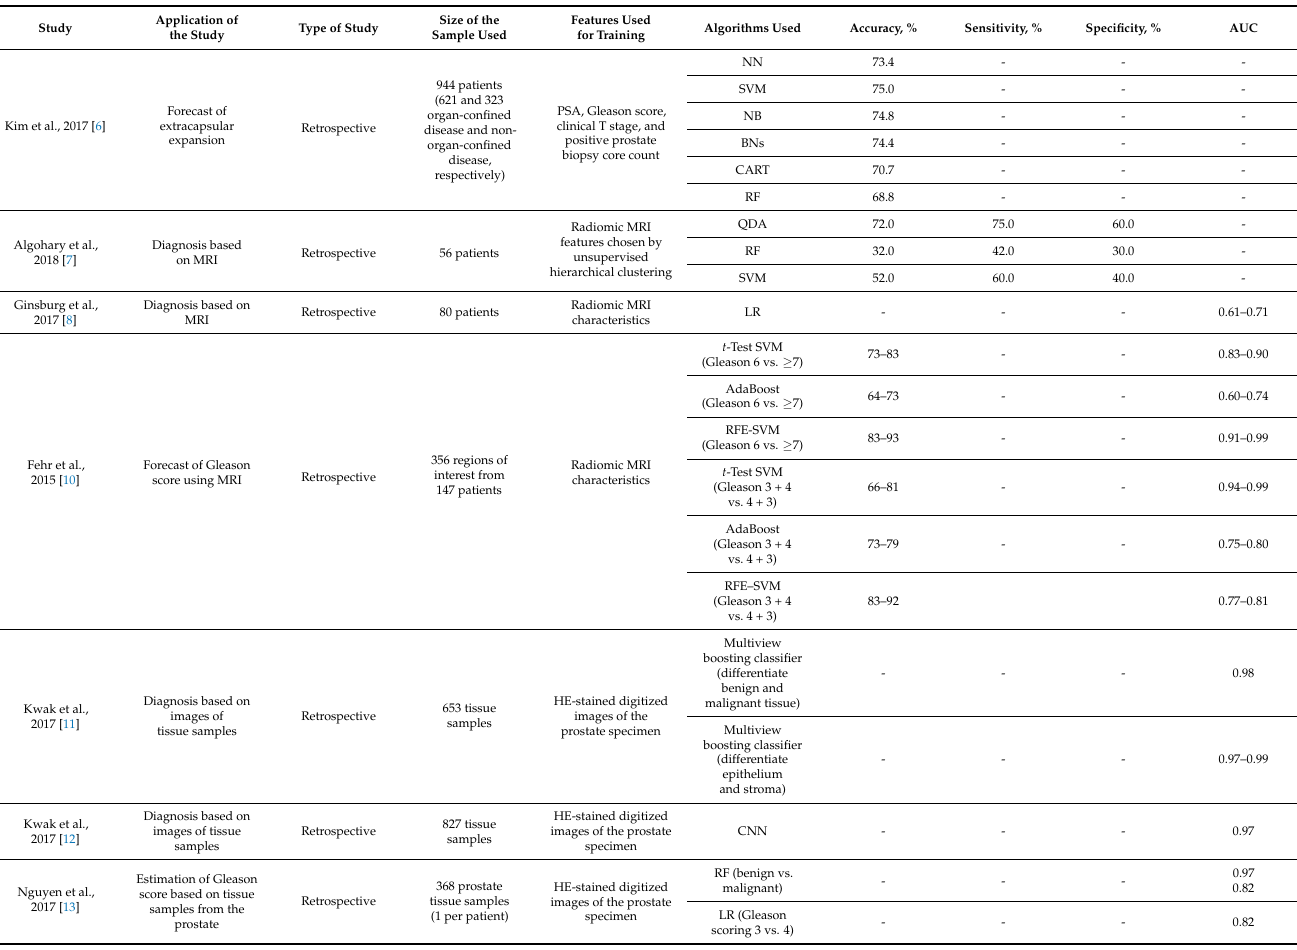
Table 1. Studies using AI to diagnose prostate